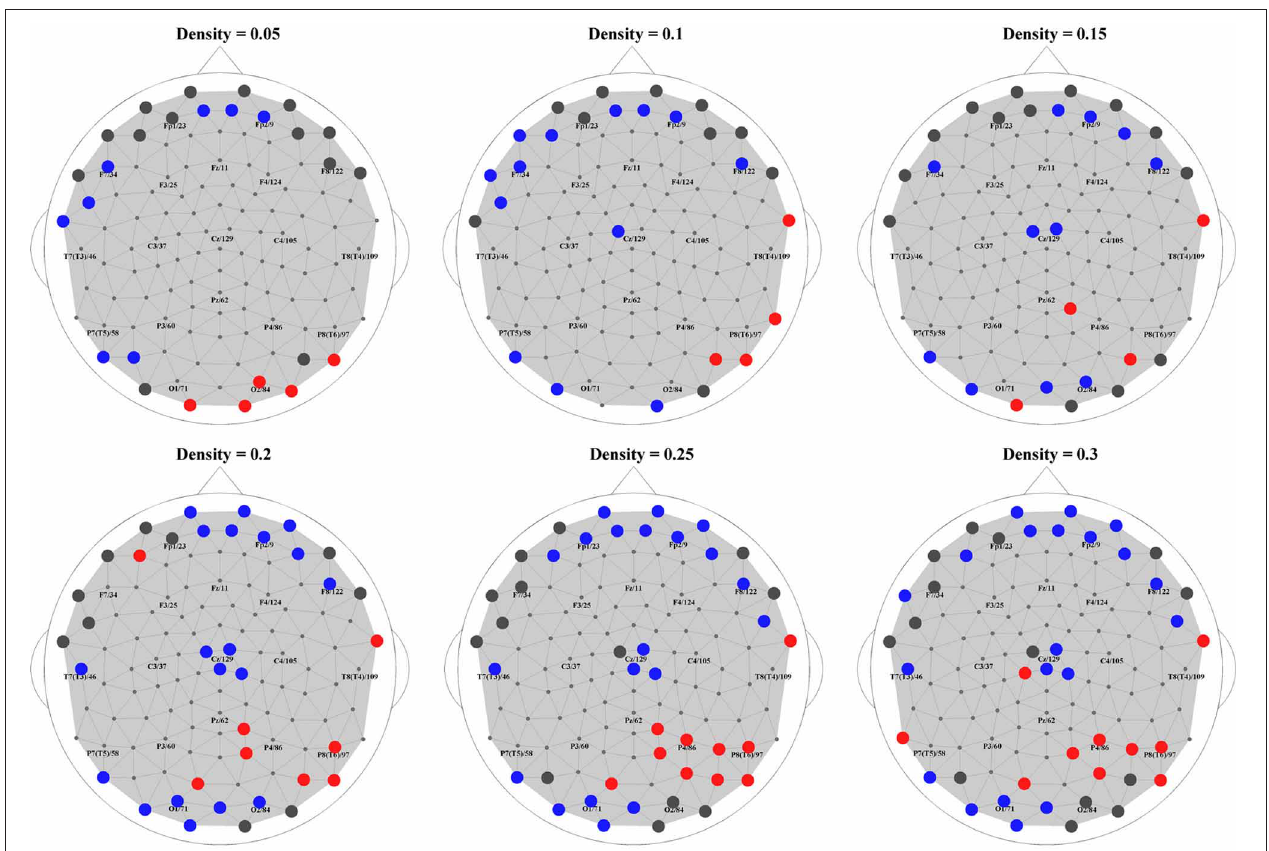
FIGURE 6 | Hubs in PNES and controls. The picture shows hub nodes in EEG alpha band. Large dark gray circles show the hub that are common in PNES patients and controls, while red circles show the hubs in PNES